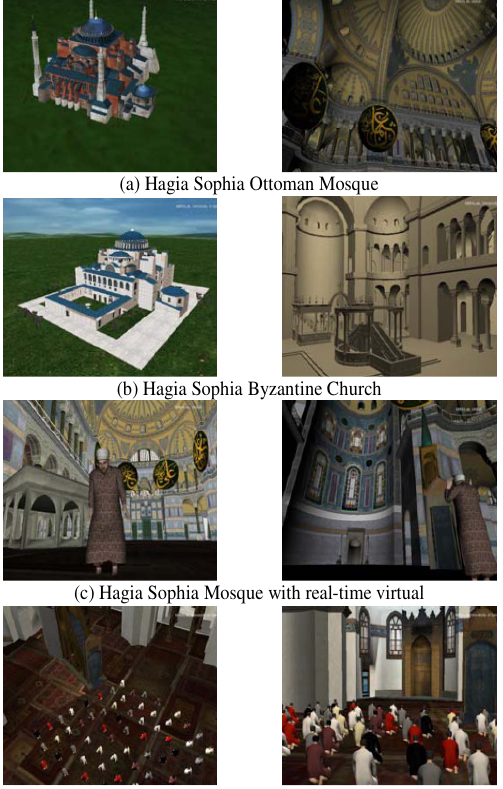
Figure 5. VHD++ real-time framework (Hagia Sophia) (Foni et al, 2003).